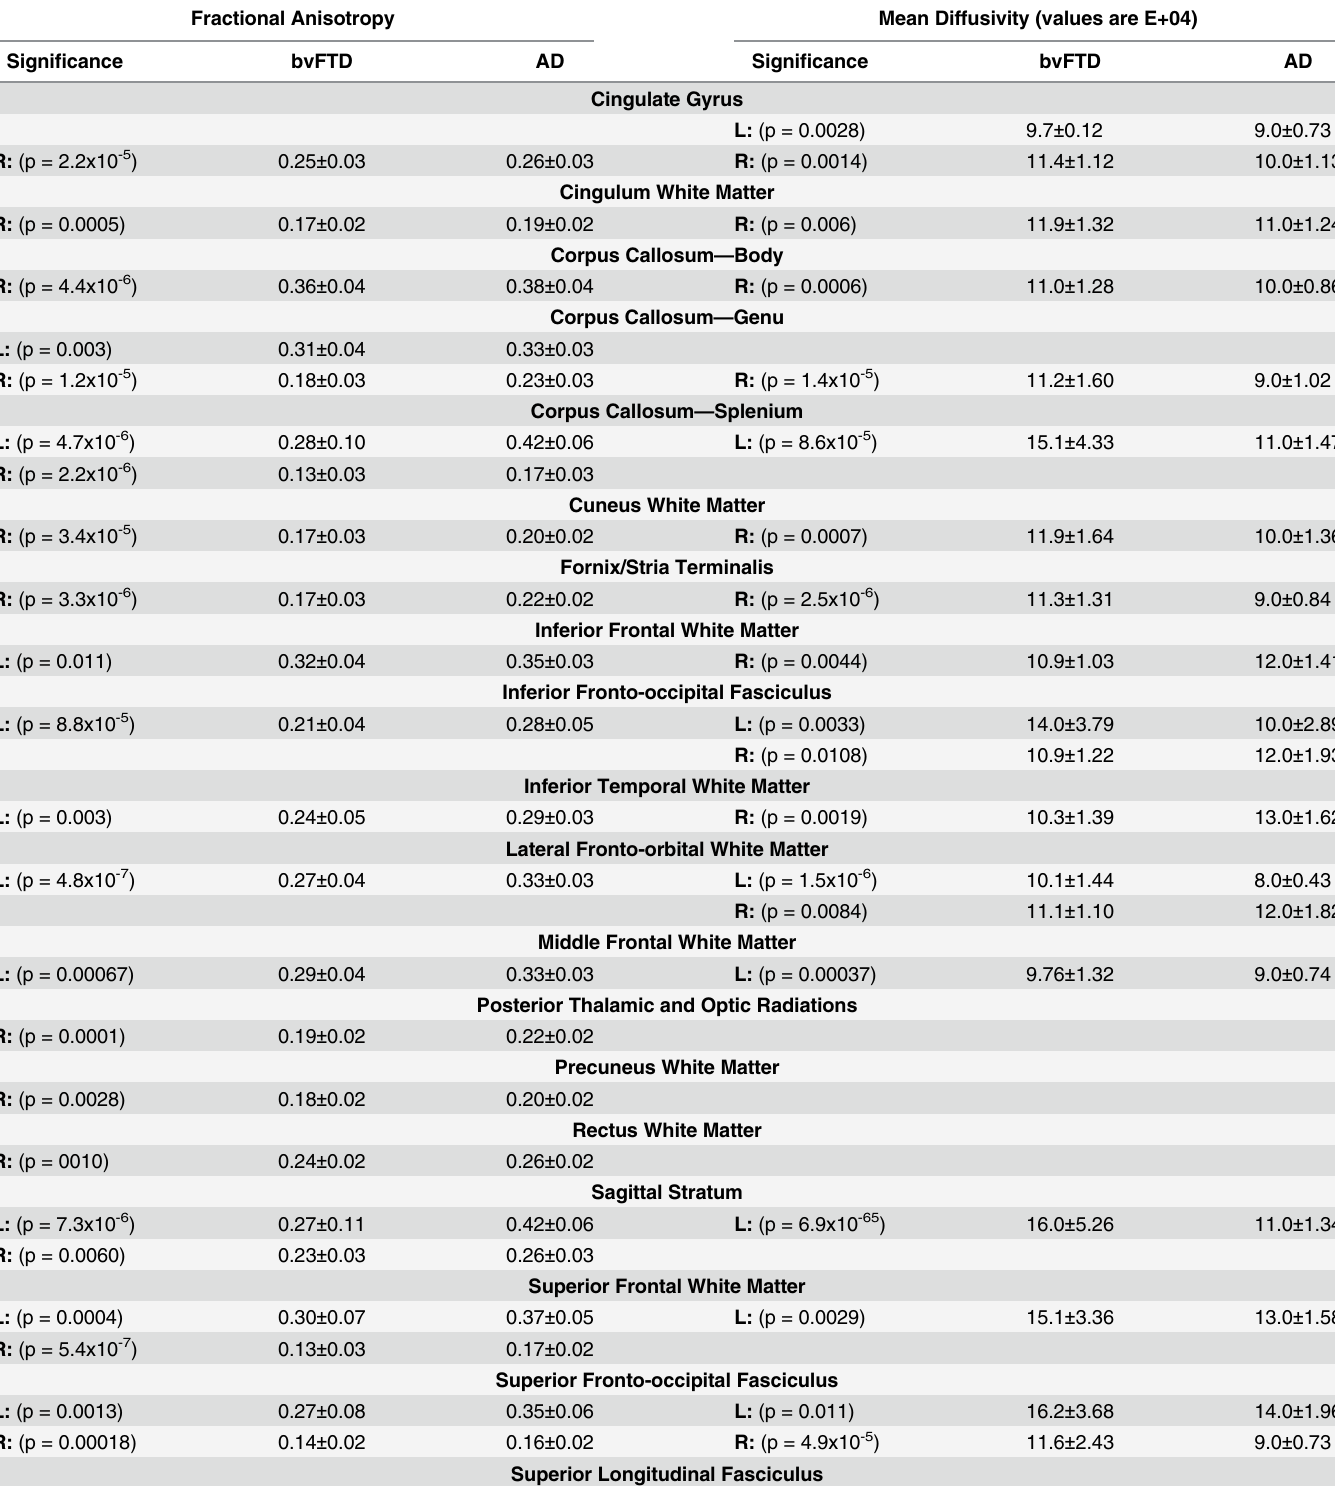
Table 3. Significant Fractional Anisotropy (FA) and Mean Diffusivity (MD) White Matter Values for patients with behavioral variant Frontotemporal Dementia (bvFTD) vs. Alzheimer ’ s Disease (AD) (L = Left Hemisphere; R = Right Hemisphere). Fractional Anisotropy Mean Diffusivity (values are